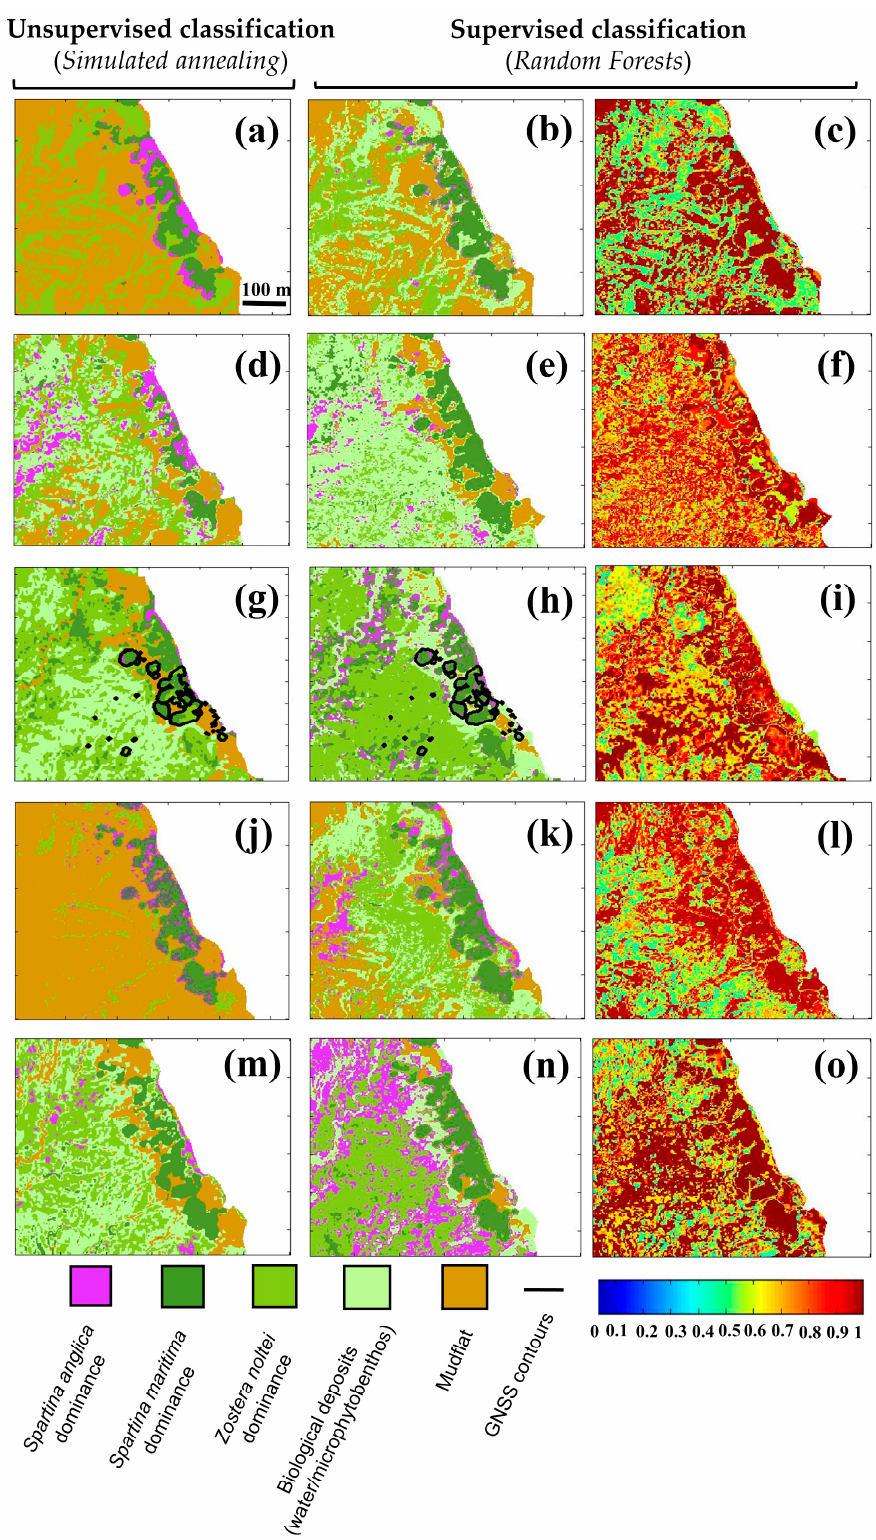
Figure 9. Pixel classification using the unsupervised method, Simulated annealing (left panel), with the supervised method, Random Forests (central panel), and classification accuracy maps for the supervised classification (right panel). ( a – c ) 25 April 2013, ( d – f ) 3 August 2016, ( g – i ) 6 October 2016, ( j – l ) 24 May 2017, and ( m – o ) 7 October 2017. Black contours on the image acquired on 6 October 2016 correspond to the field ground truth GNSS vegetation contours. Color bar indicates the confidence level of class attribution in the accuracy